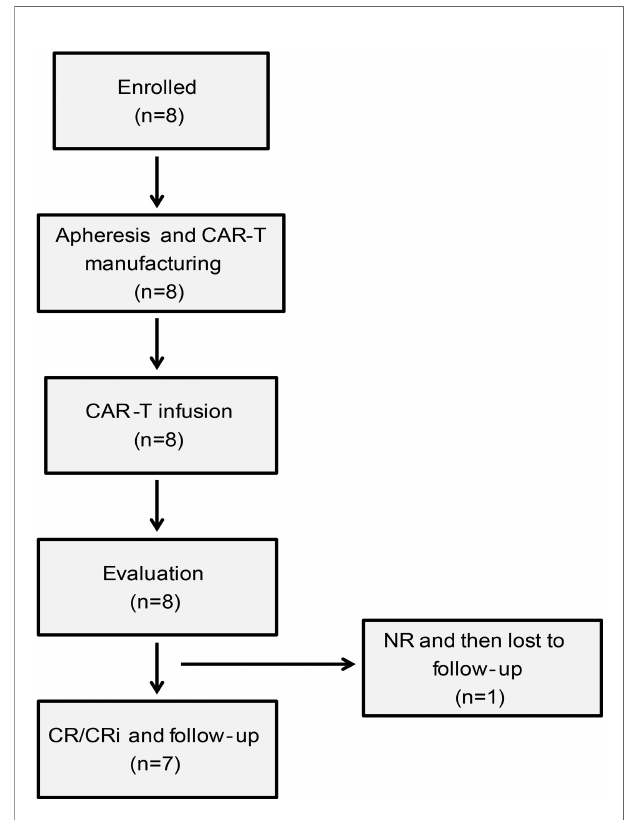
FIGURE 1 | The fl owchart of CD19hsCAR-T